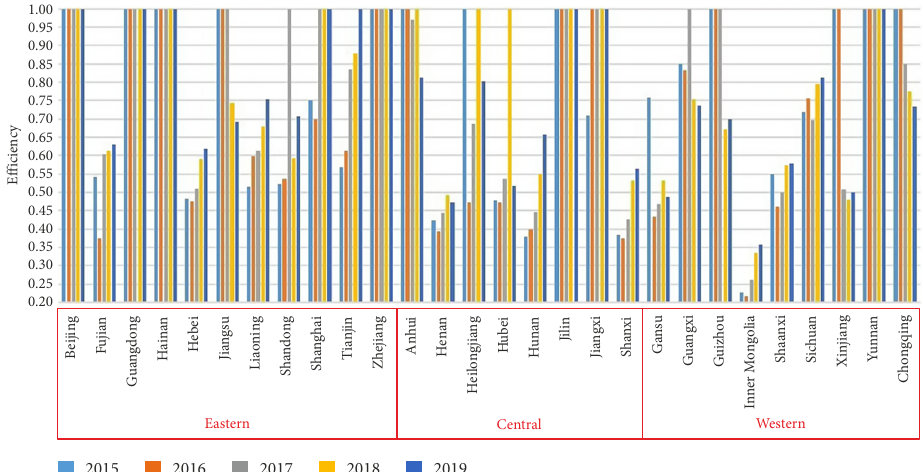
Figure 6. 2015–2019 China’s regional industrial innovation